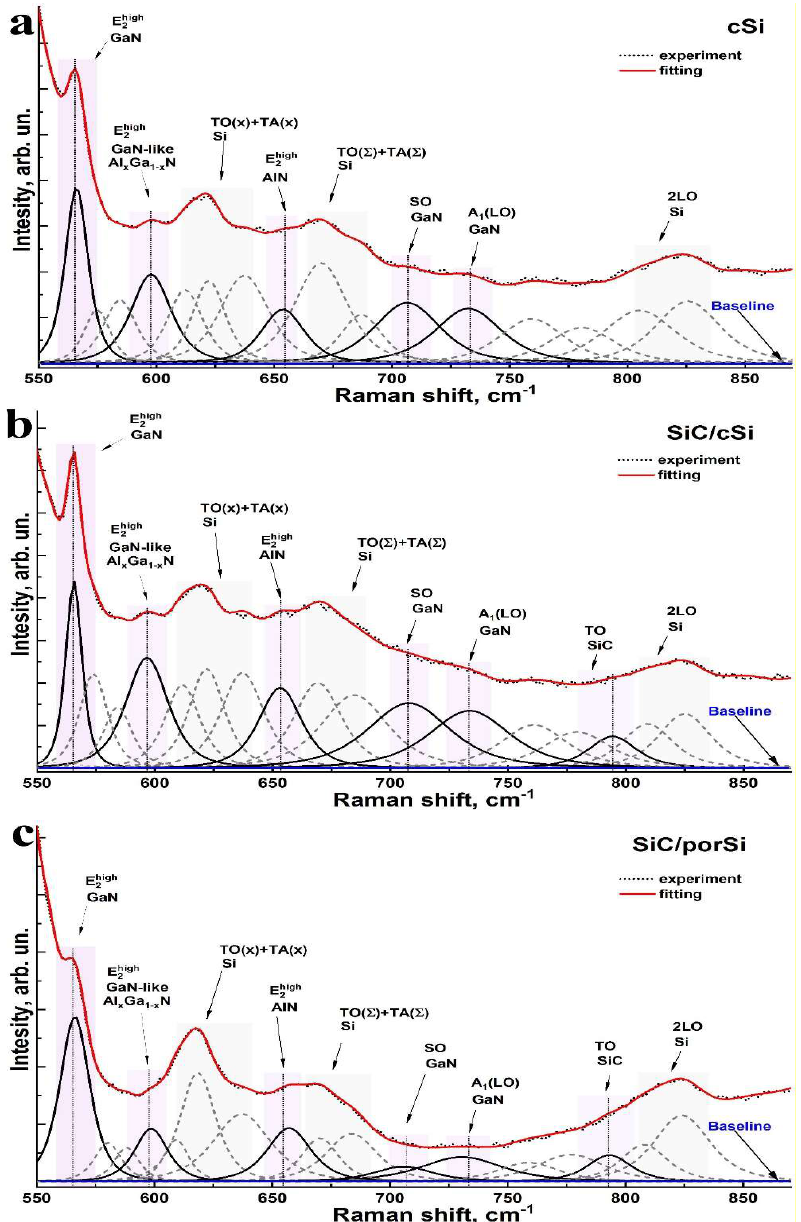
Figure 4. Results of the Raman spectra decomposition of heterostructures grown on cSi, SiC/cSi, and SiC/porSi substrates. Table 1. Frequencies of the fundamental vibrations attributed to GaN, AlN, and Al x Ga 1− x N from the Raman spectra decomposition results.